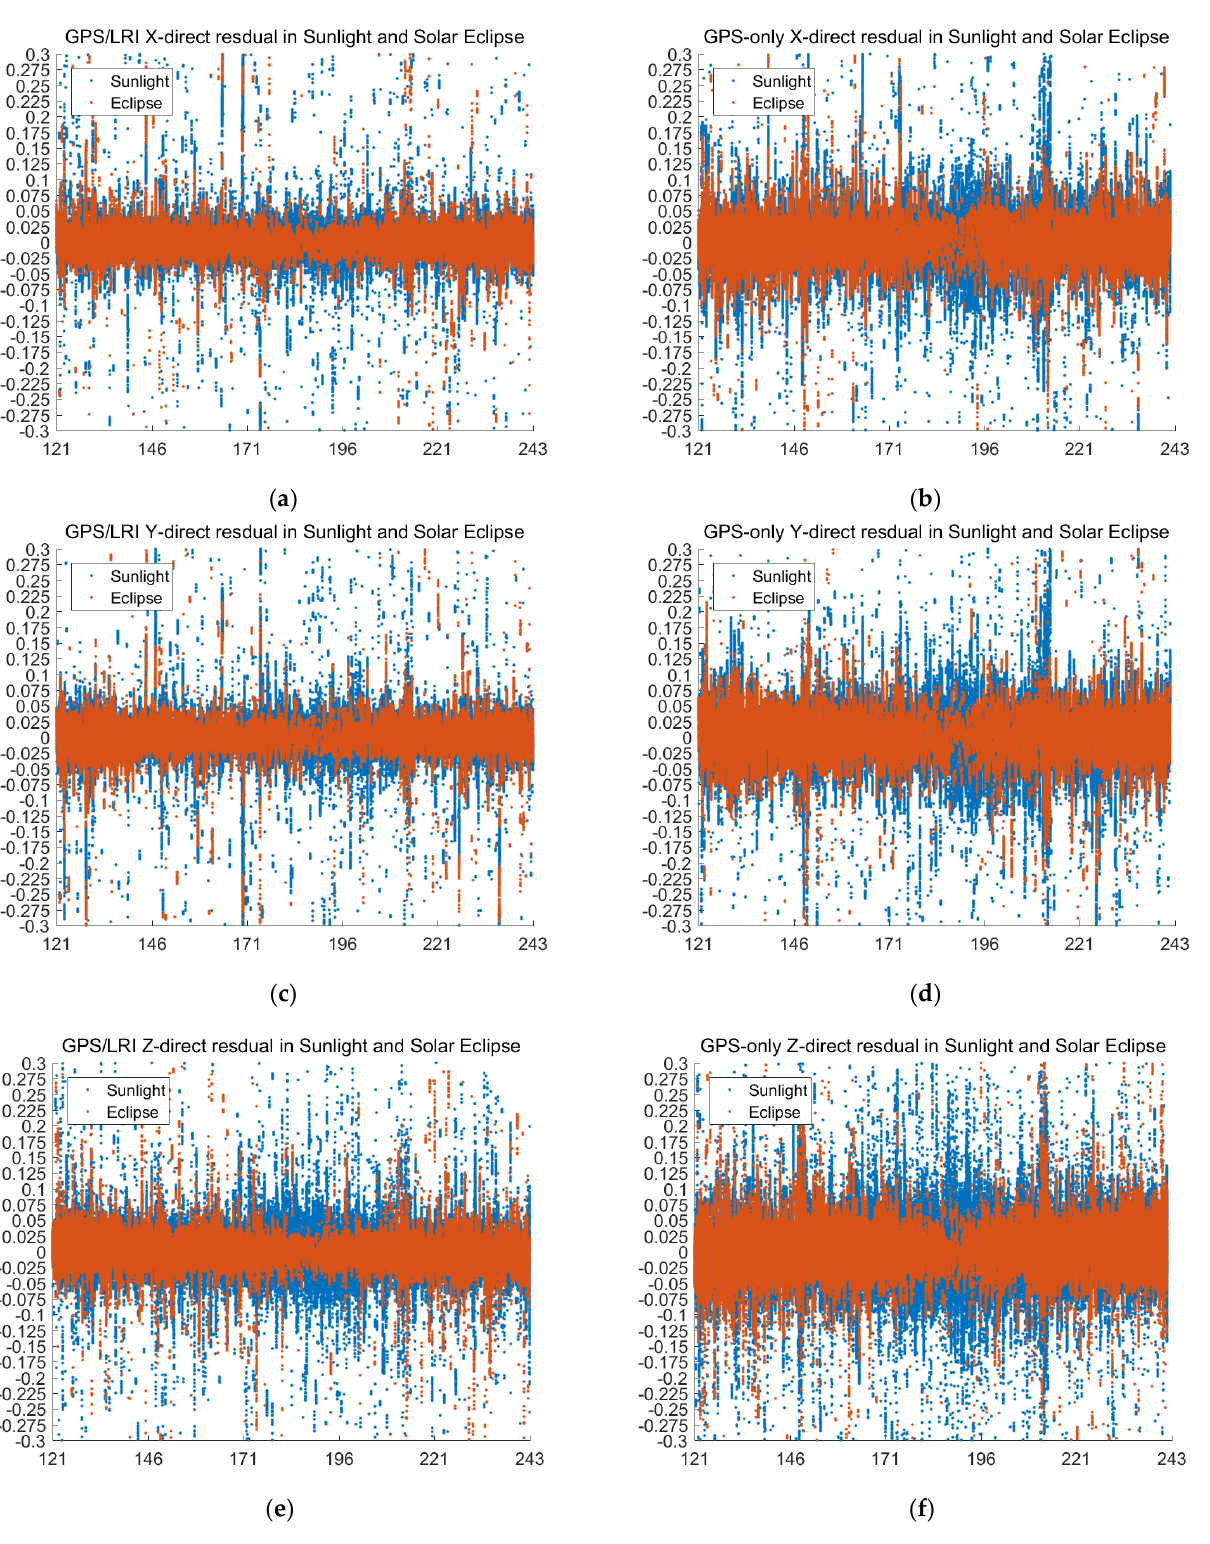
Figure 12. D (X, Y, Z are components of the baseline vector, unit: m, ( a – d )) directions (days 121–242).